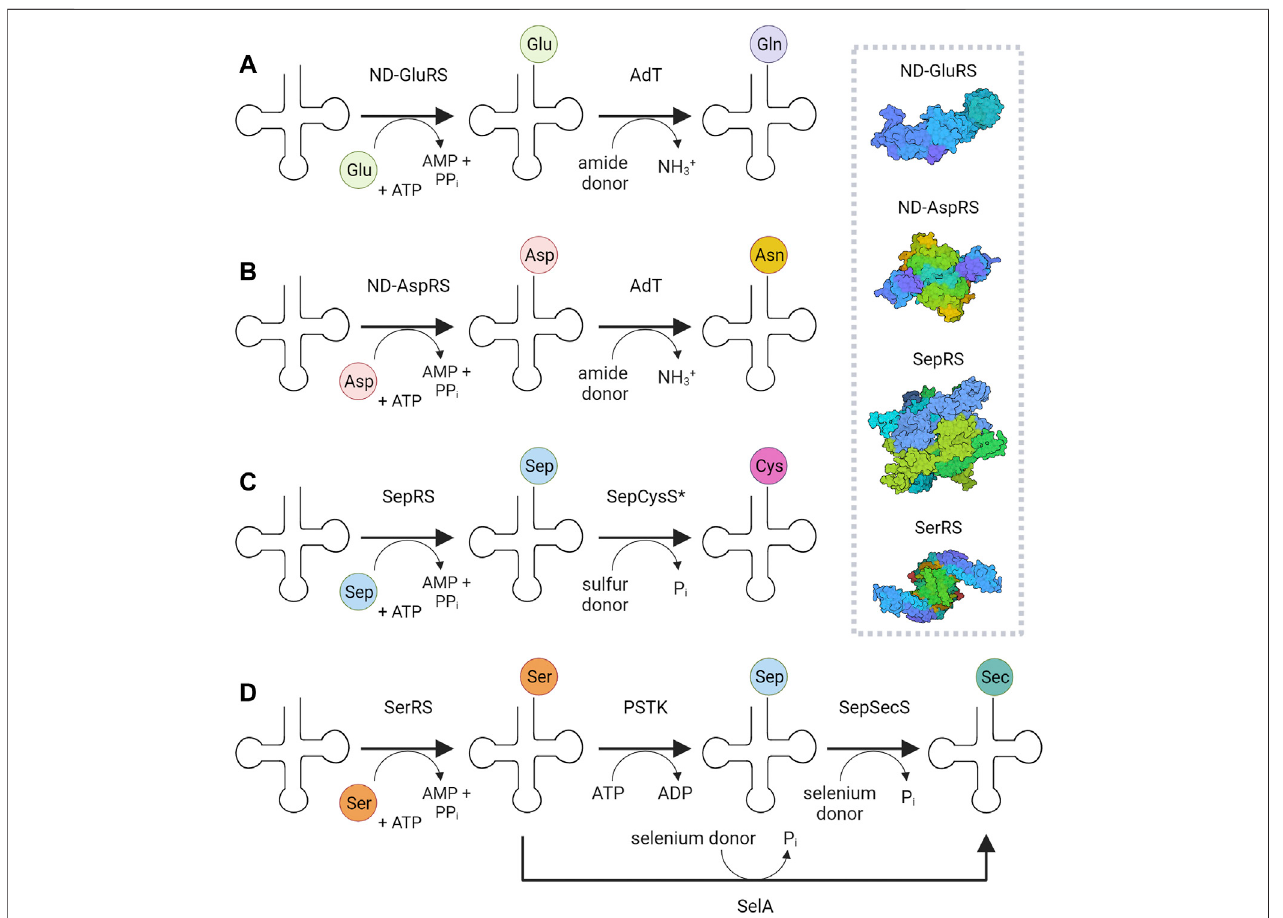
FIGURE 1 | Indirect pathways to glutaminyl- (A) , asparaginyl- (B) , and cysteinyl-tRNAs (C) , and selenocysteinyl-tRNA (D) . The surface representation of the corresponding aaRSs is shown: ND-GluRS — non-discriminating glutaminyl-tRNA synthetase (PDB id: 2CFO) (Schulze et al., 2006); ND-AspRS — non-discriminating aspartyl-tRNA synthetase (PDB id: 1N9W) (Charron et al., 2003); SerRS — seryl-tRNA synthetase (PDB id: 4L87) (Xu et al., 2013); SepRS — O -phosphoseryl-tRNA synthetase (PDB id: 2ODR) (Kamtekar et al., 2007). AdT — amidotransferase, SepCysS — Sep-tRNA:Cys-tRNA synthase, PSTK — O -phosphoseryl-tRNA